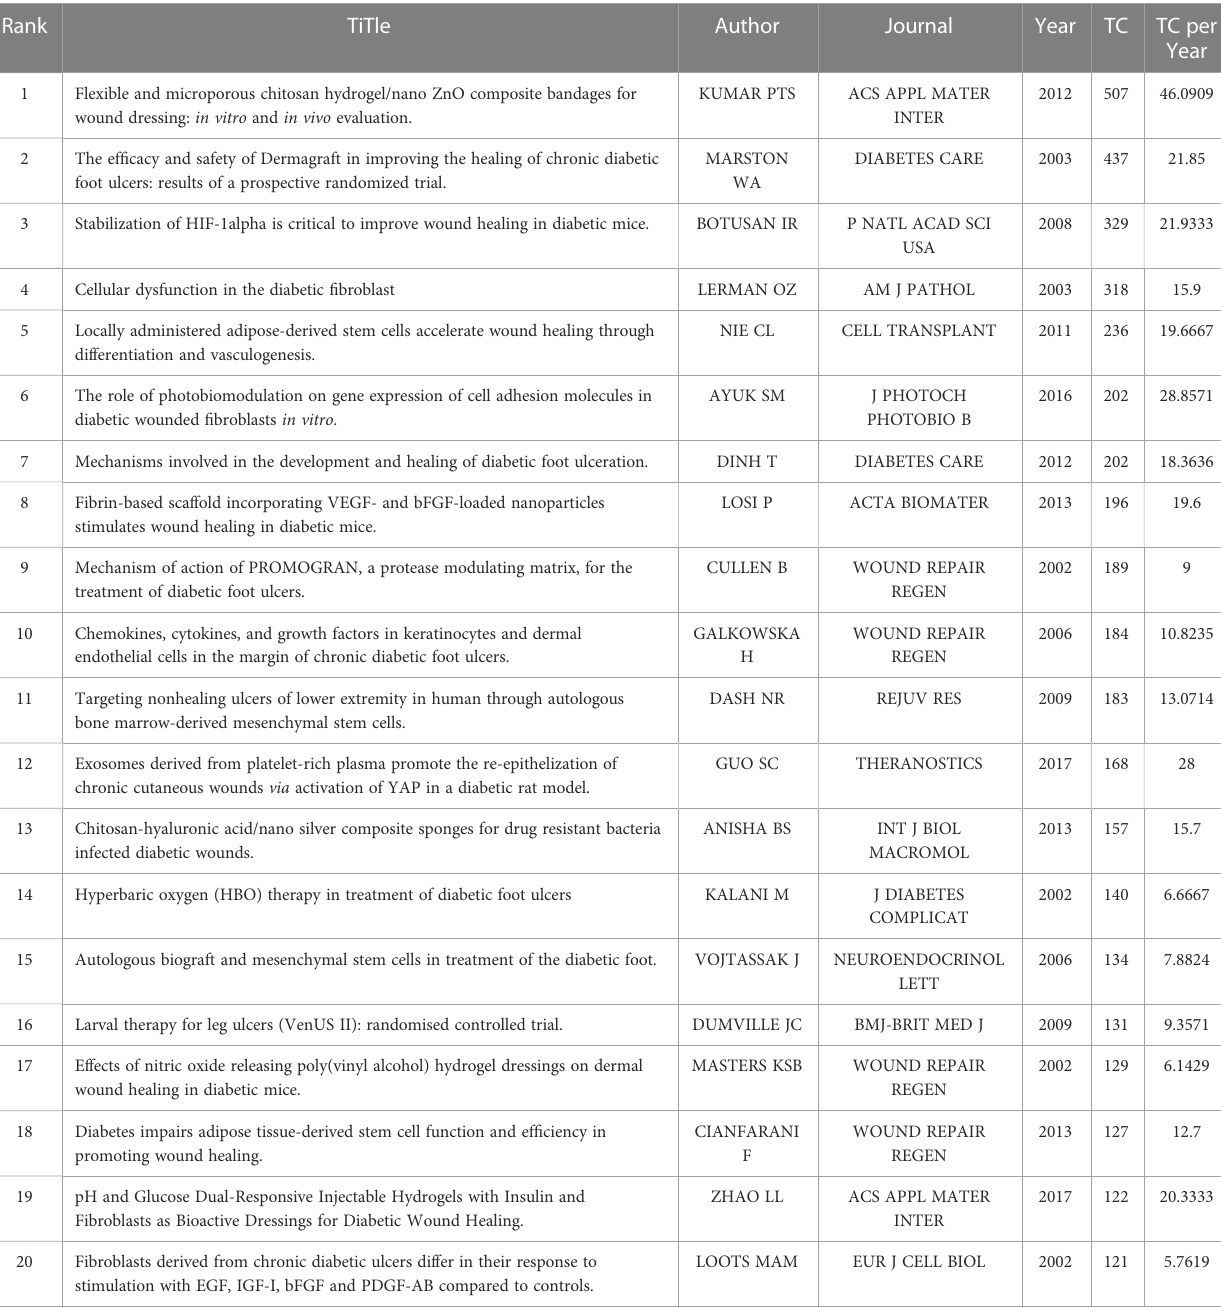
TABLE 3 Top 20 most global cited documents on fi broblast-related DFUs research. Rank